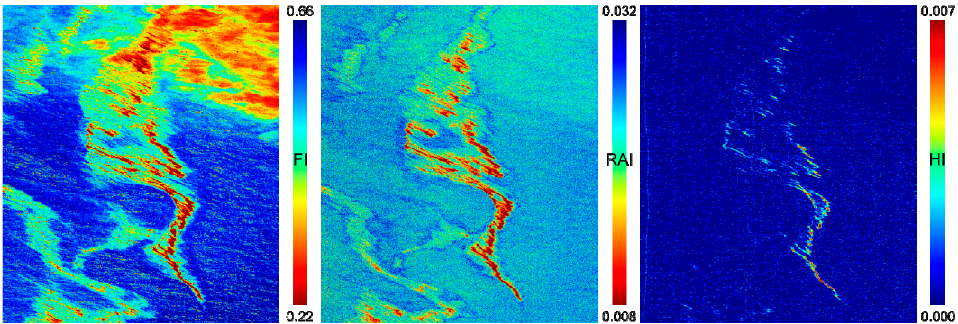
Figure 10. Score maps obtained with the spectral indices: ( left ) FI; ( center ) RAI; and ( right ) HI. Color code for HI is inverted in order to assign hot colors to the presence of oil emulsion.